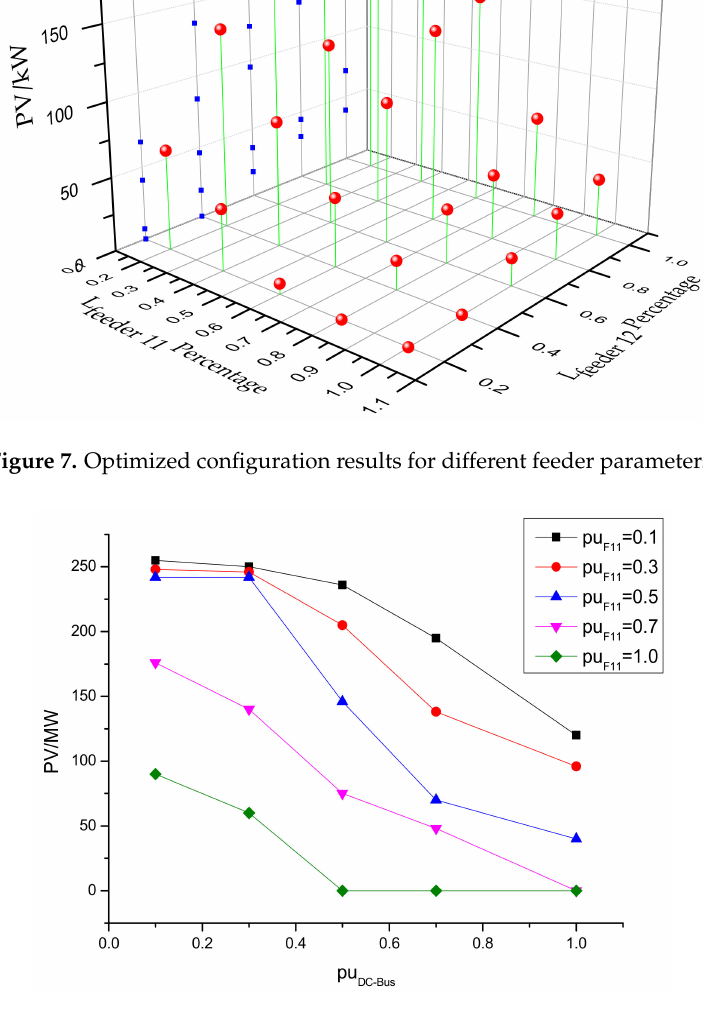
Figure 8. Optimized configuration results for different DC bus